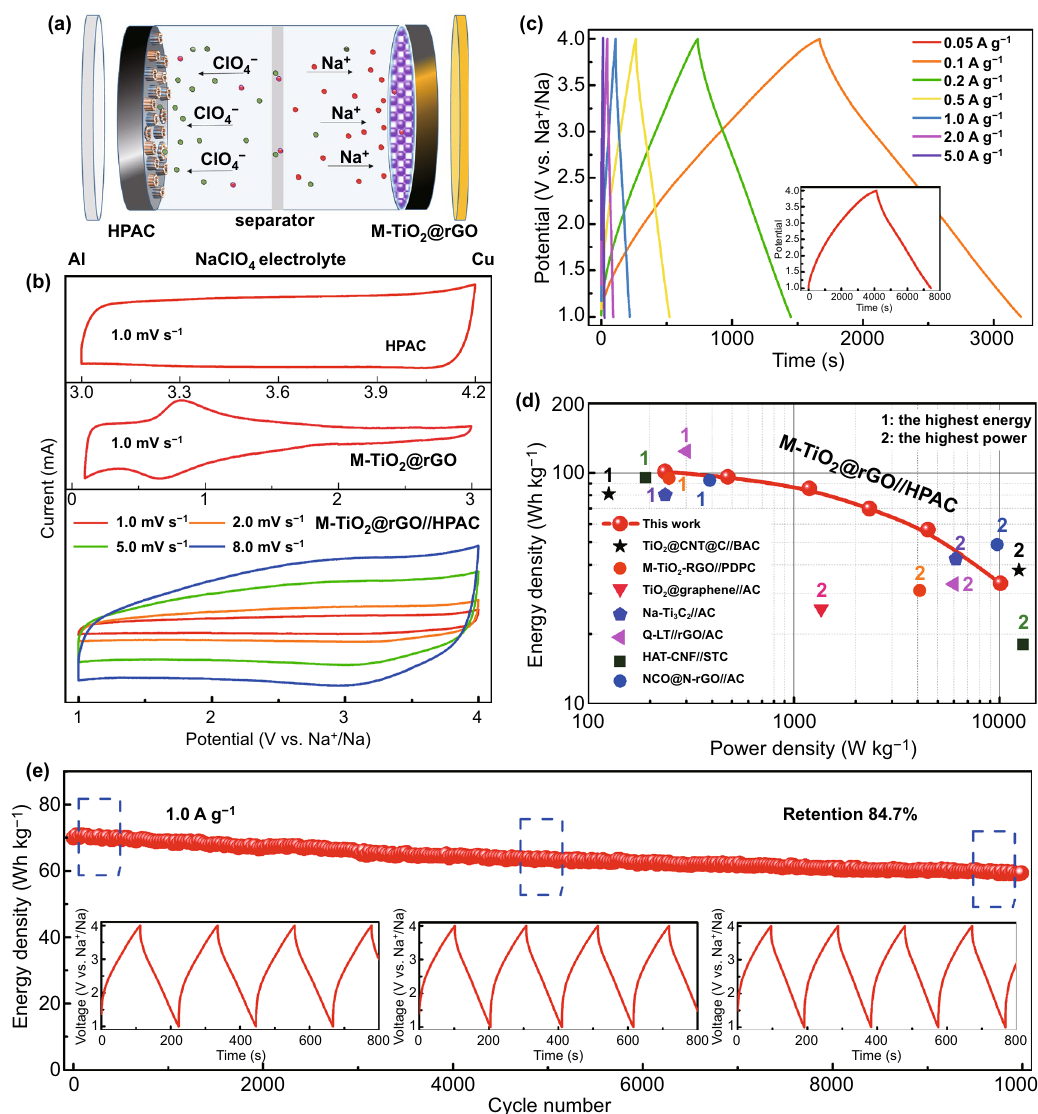
Fig. 7 Electrochemical performance of the sodium ion capacitors (SICs) with HPAC as cathodes and coated M‑TiO 2 @rGO as anodes. a Sche‑ matic of the SICs; b CV curves of HPAC, M‑TiO 2 @rGO, and M‑TiO 2 @rGO//HPAC; c CP curves at different current densities; d Ragone plot of power density and energy density; and e cycling performance at 1.0 A g −1 , inset: CP curves at different